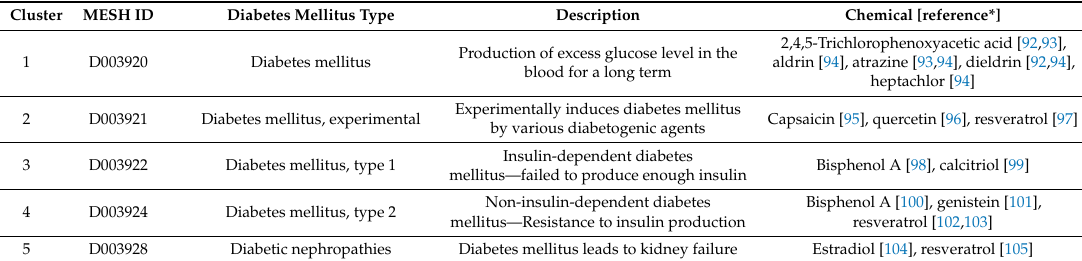
Table 1. Androgenic compounds and the associated types of diabetes mellitus.